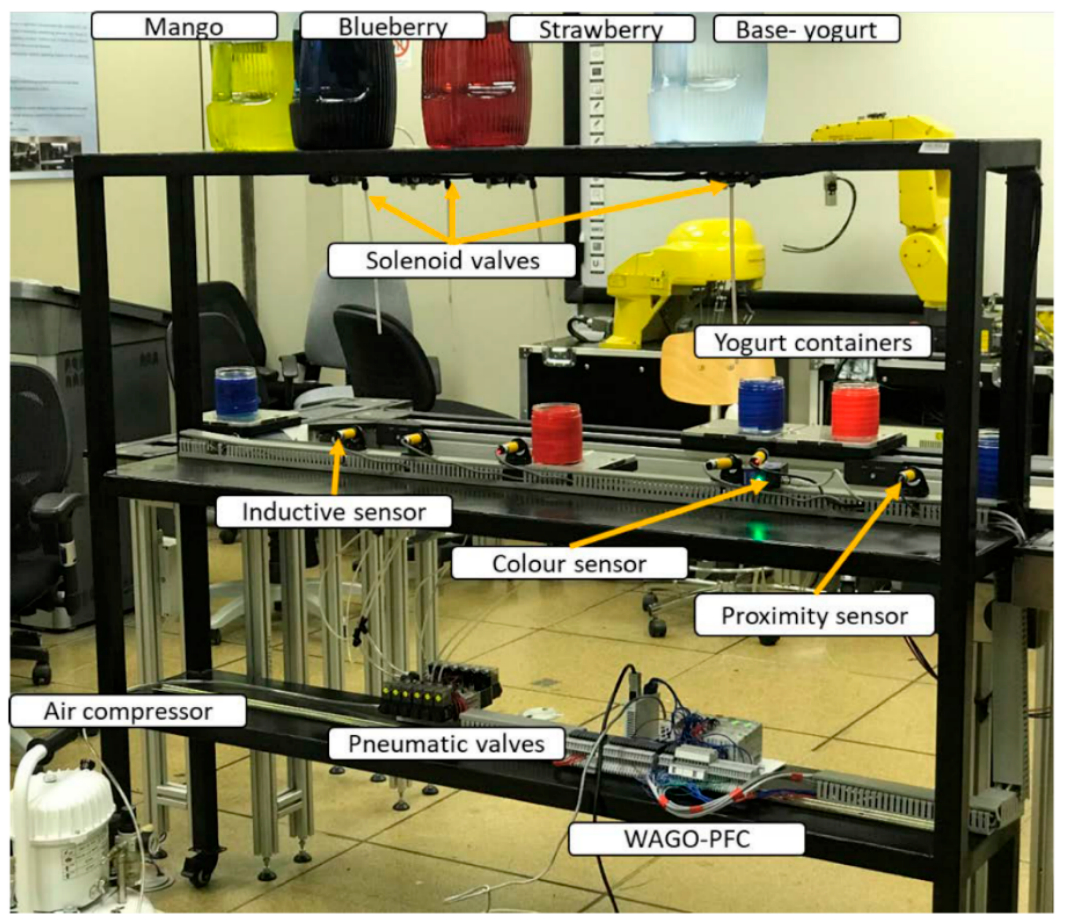
Figure 1. The automatic yogurt filling system.